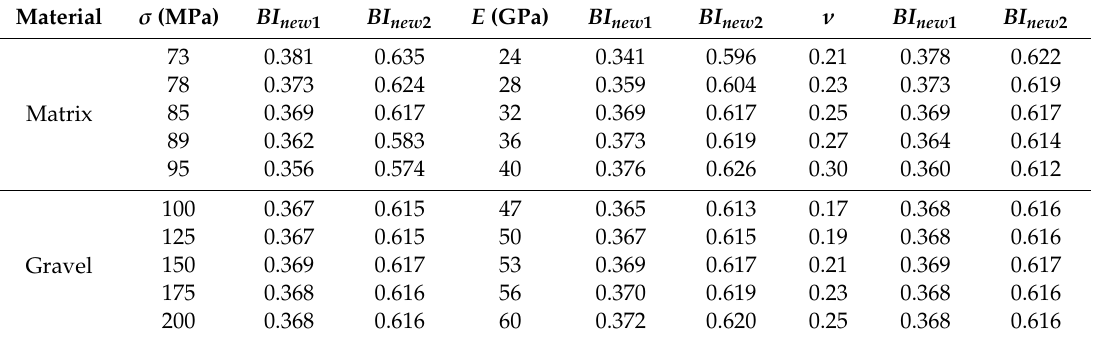
Table 5. Mechanical parameters for numerical tests and their corresponding brittleness indexes.